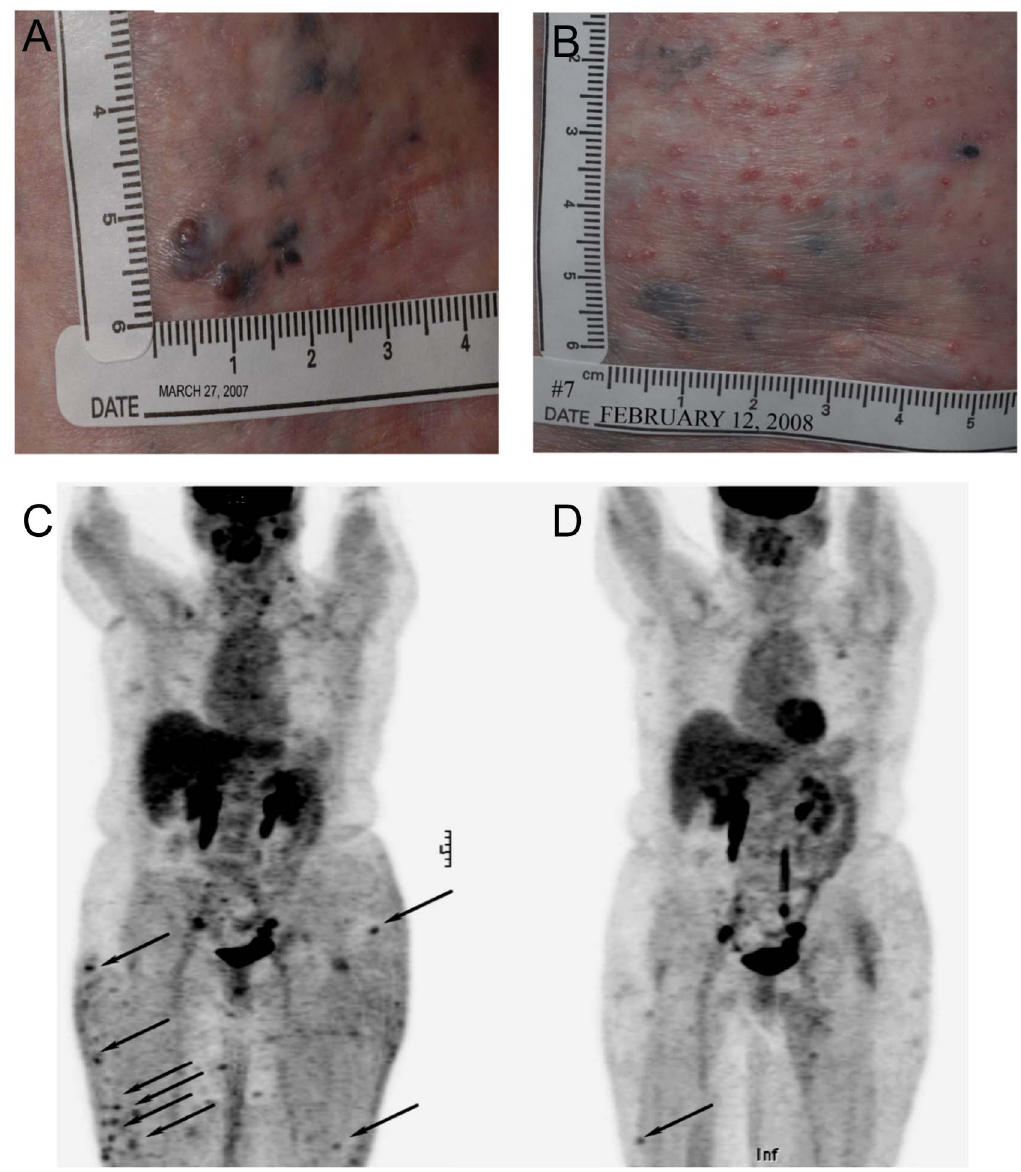
Figure 4. Partial response in Patient 007 with metastatic melanoma receiving GC1008. Patient was previously treated with multiple surgical resections, adjuvant interferon-alpha, interleukin-2, combination chemotherapy, hyperthermia, investigational anti-melanoma vaccines, and ipilimumab and then progressed and presented with extensive cutaneous and subcutaneous metastatic disease. The patient received GC1008 initially at 1 mg/kg 6 4 doses followed by 2 courses of Extended Treatment at 3 mg/kg 6 4 doses and 15 mg/kg 6 4 doses and achieved a partial response with 89.6% decrease in size of her target lesions. Reduction of cutaneous lesions were noted by serial measurements (Panel A baseline, Panel B day 308) and by PET scans (Panel C baseline, Panel D day 218 following 8